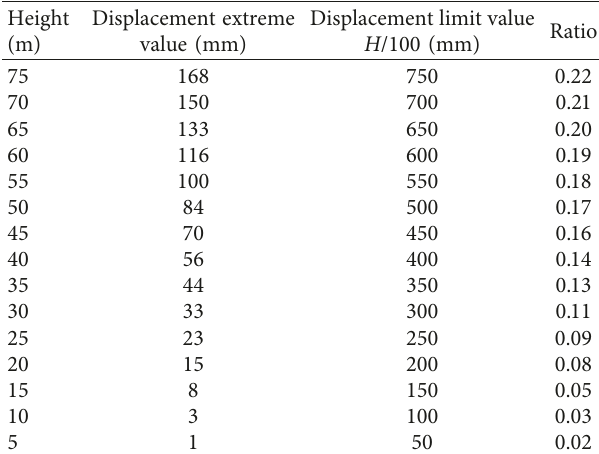
Table 3: Displacement amplitudes under frequent earthquake conditions.